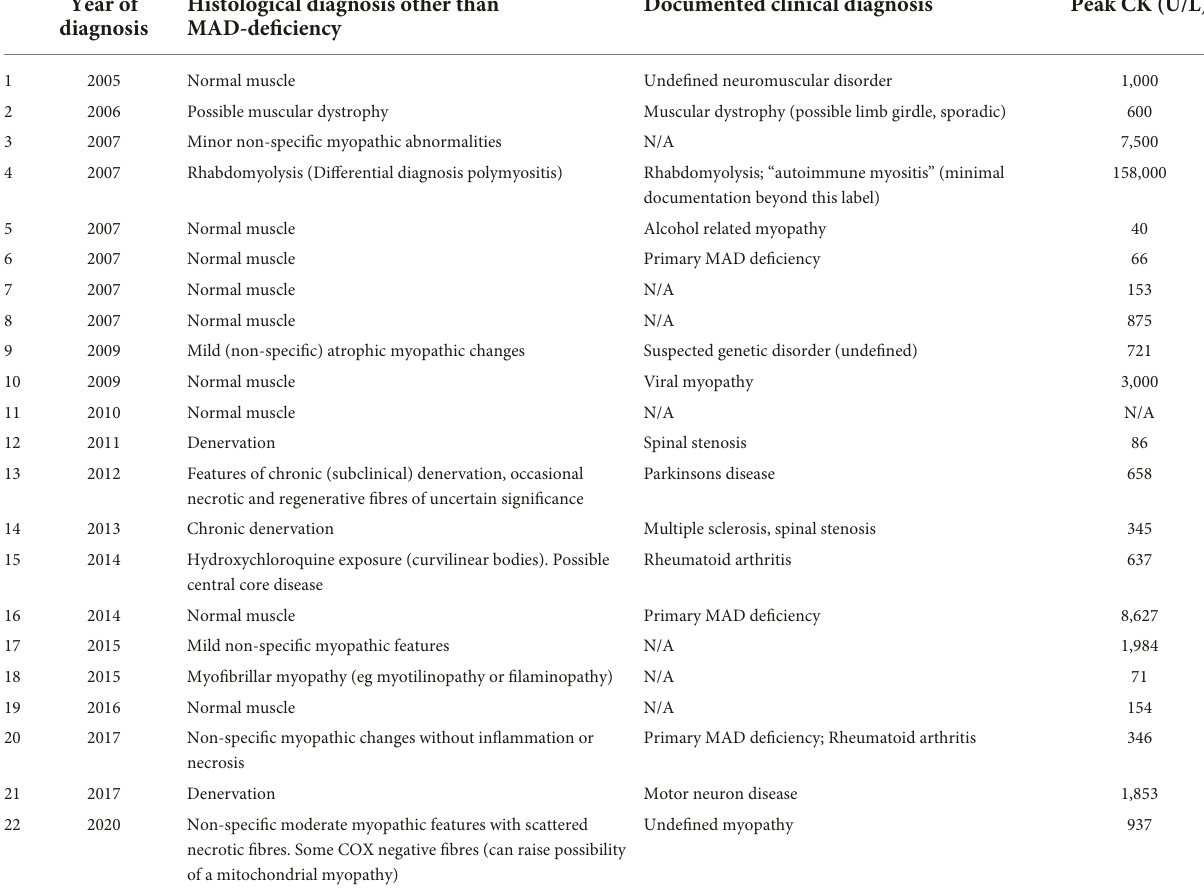
TABLE 2 Characteristics of myoadenylate deaminase-deficient cases without myositis. Year of